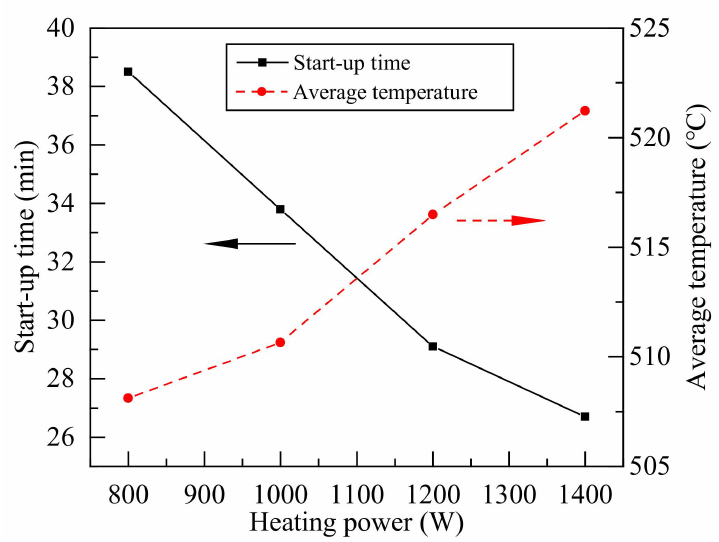
Figure 7. Start-up time and average temperature of evaporator section during the each boiling under different heating power.